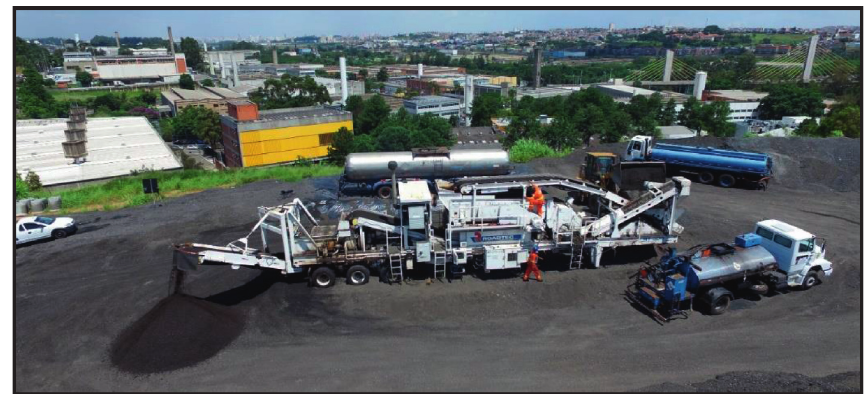
Figure 2: Cold in-place recycling train set up as a stationary cold central plant